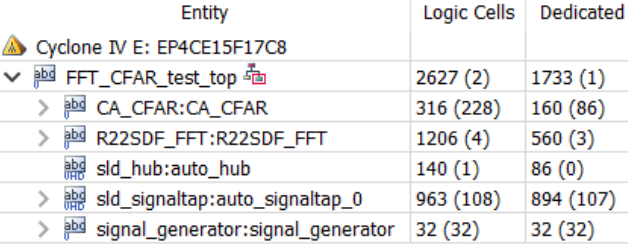
Figure 13. Comparison of the effect of threshold detection.